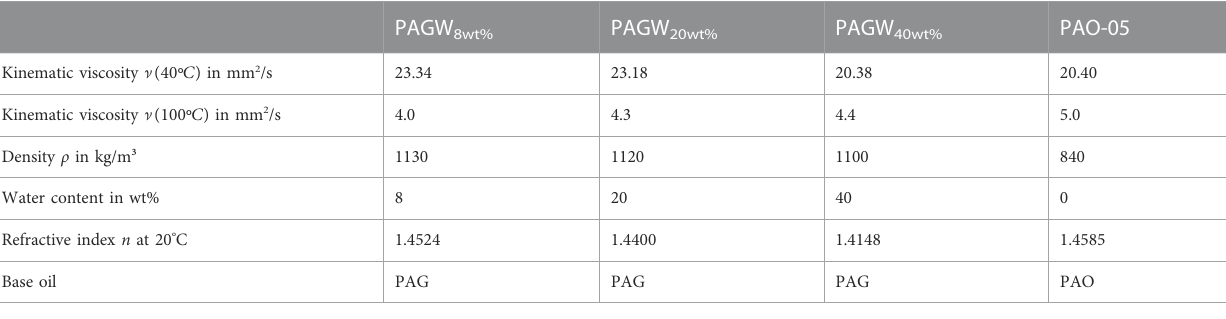
TABLE 1 Properties of the investigated lubricants (*Kinematic viscosity at 100 ° C extrapolated for water-containing lubricants).